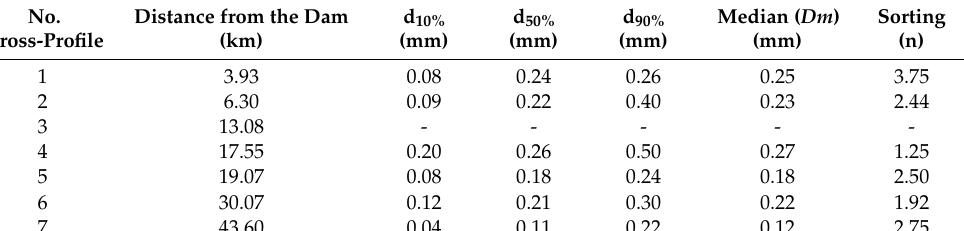
Table 3. Characteristic sediment particle size composition for the monitored cross profiles of the Dnieper river downstream of the Kaniv HPP for sediments sampled in 2015.